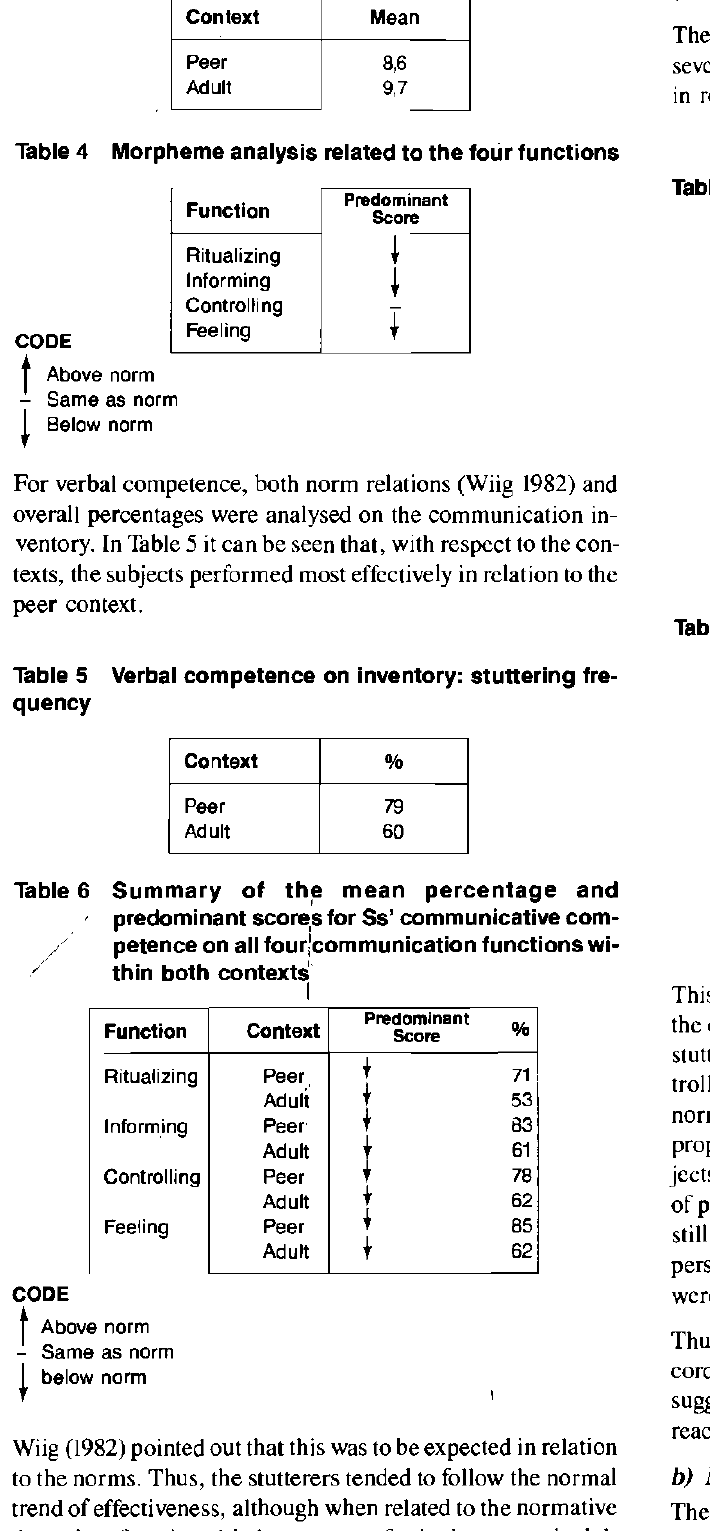
Table 3 Morpheme analysis related to the two contexts